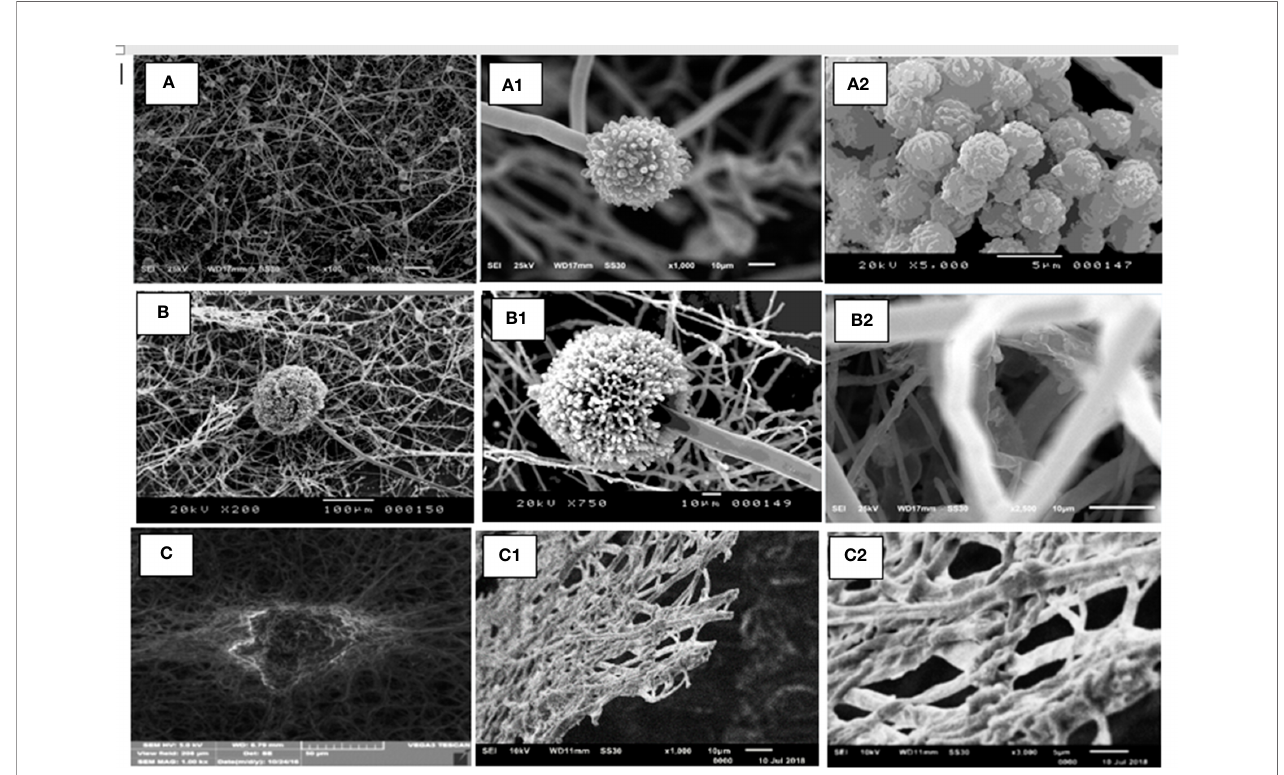
FIGURE 2 | Representative micrographs of the Aspergillus ( A – A.niger; B – A. terreus ) and Fusarium oxysporum (C) bio fi lms.